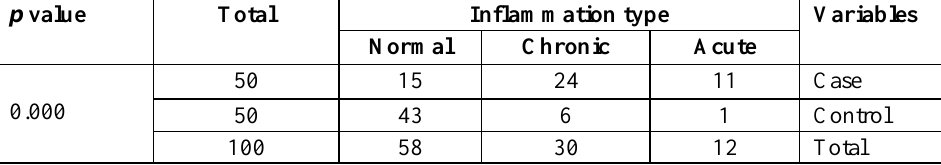
Table 3. Distribution of study population according to type of